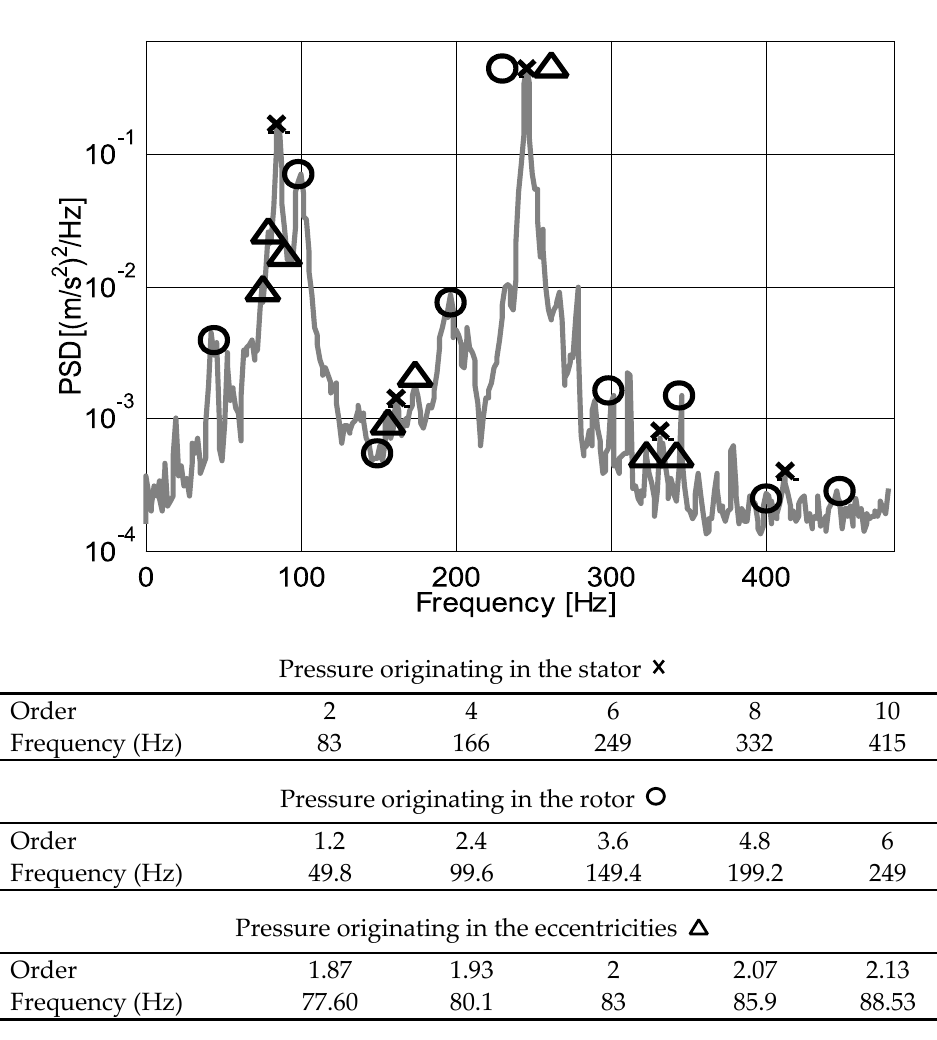
Figure 26. Analytical order identification of the experimental vibration measurements in the Qs36p15 machine.